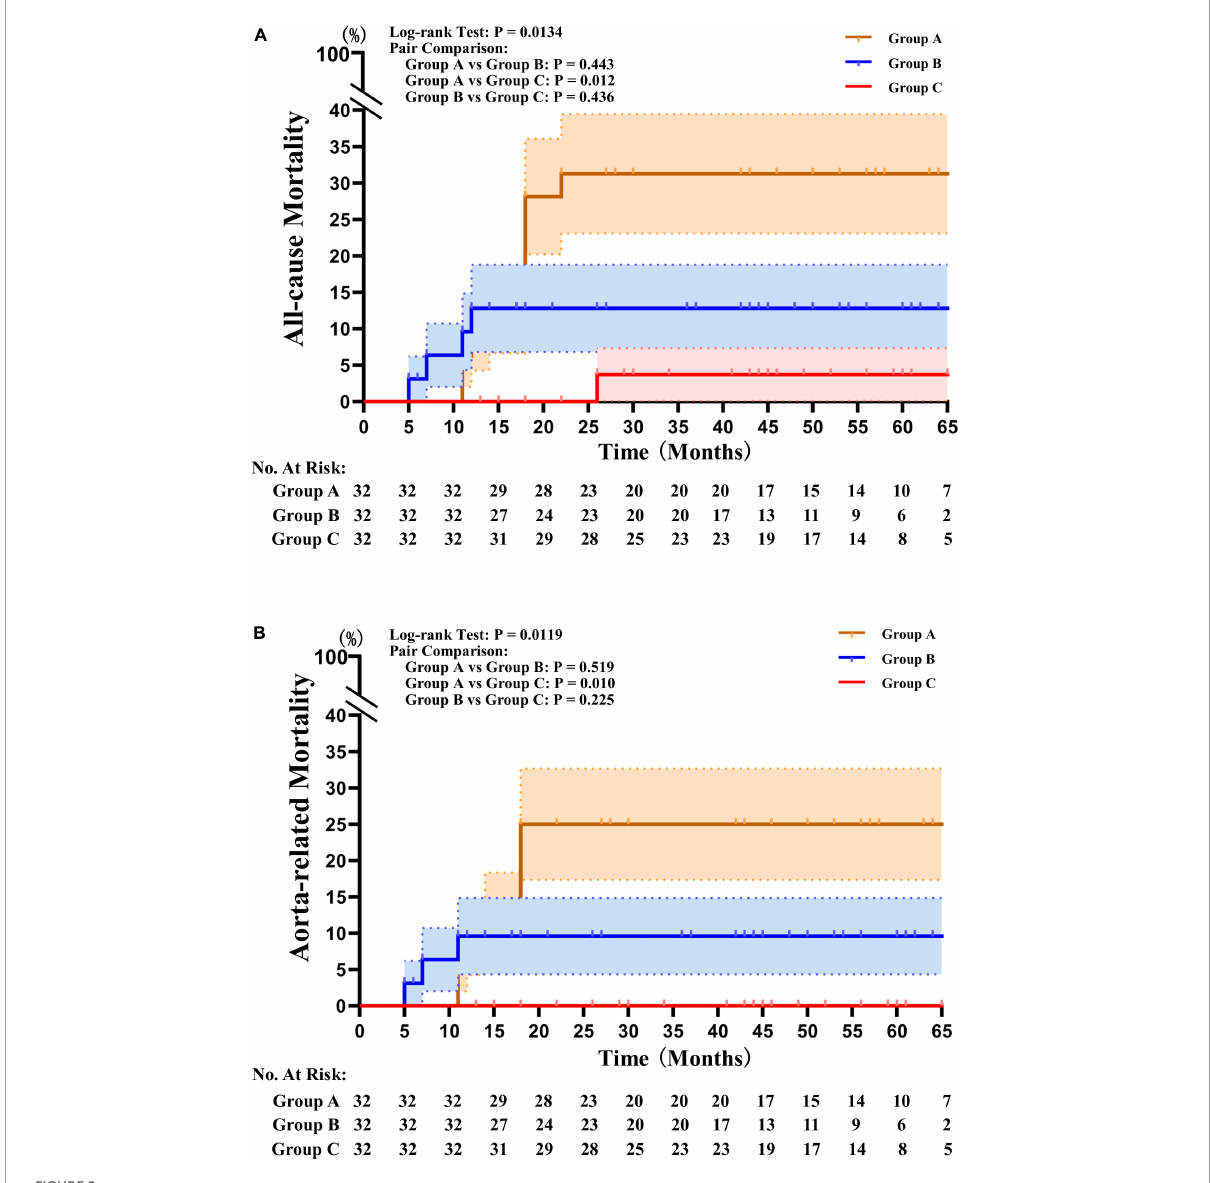
FIGURE2 Kaplan–Meier survival analysis results. (A) Kaplan–Meier survival analysis revealed that the mortality rates from all causes were significantly lower in Group C than in Groups A and B ( P = 0.0134). (B) The Kaplan–Meier survival analysis found that the mortality rates associated with the aorta were significantly lower in Group C than they were in Groups A and B ( P =